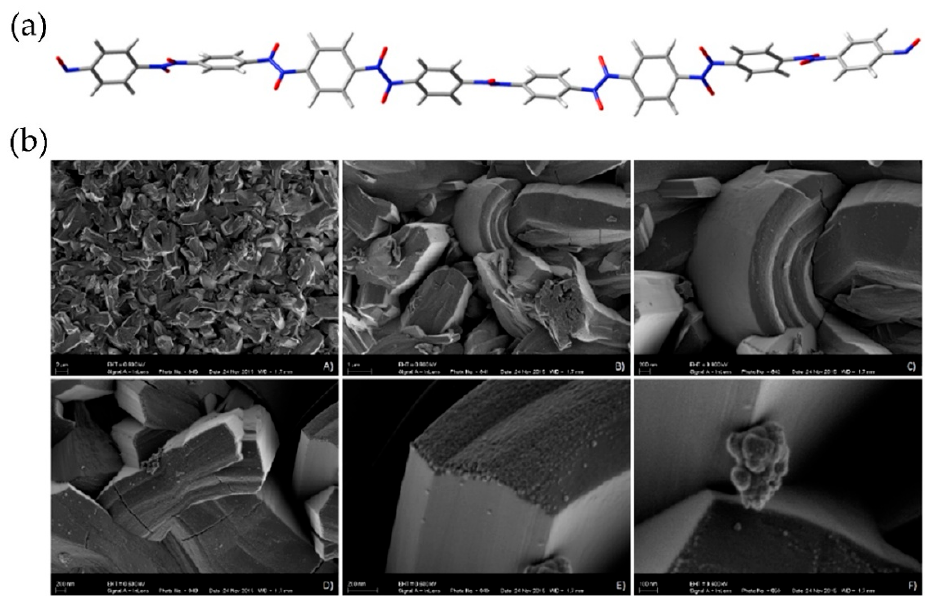
Figure 10. ( a ) Calculated helical structure of the p -dinitrosobenzene octamer. Reproduced with permission from [49]. Copyright 2016 Elsevier. ( b ) The morphology of the p -dinitrosobenzene polymer obtained by SEM microscopy [50].